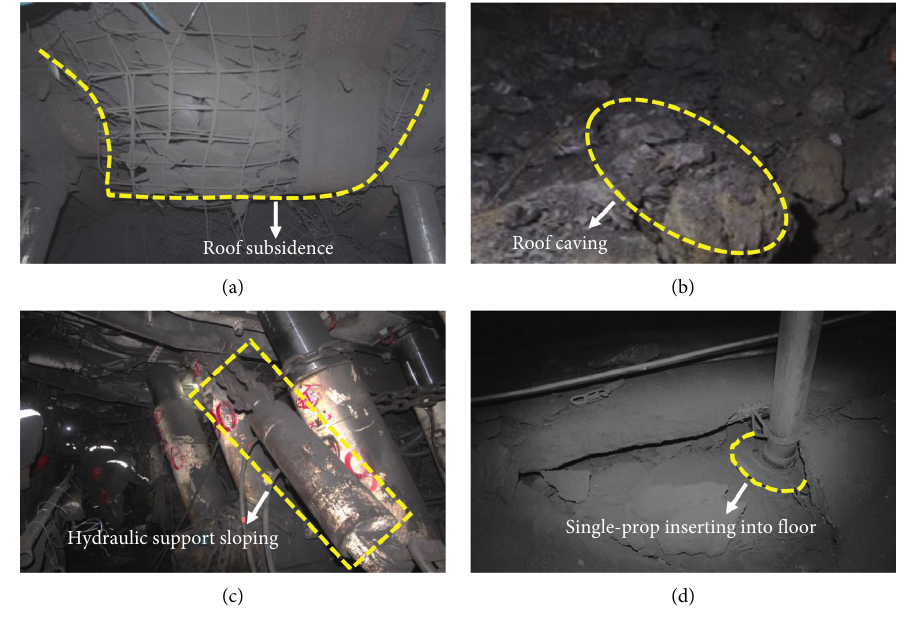
Figure 6: Failure patterns in LMTCCM of extra-thick coal seams.